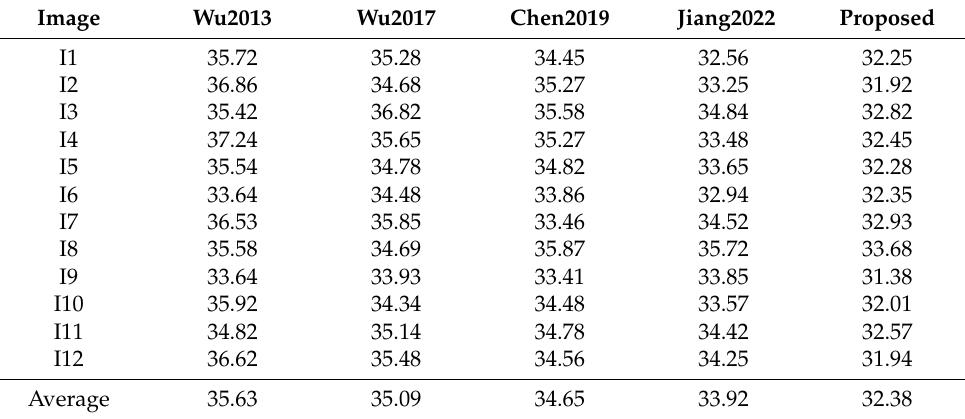
Table 2. Performance comparison results of maximum tolerable noise level based on different JND